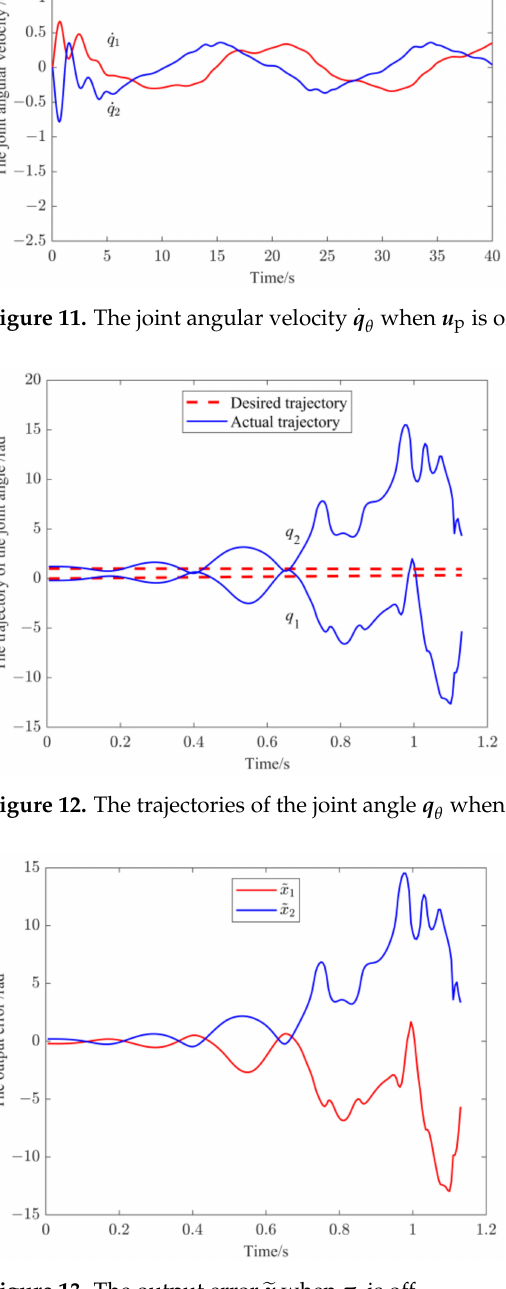
Figure 13. The output error (cid:101) x when τ f is